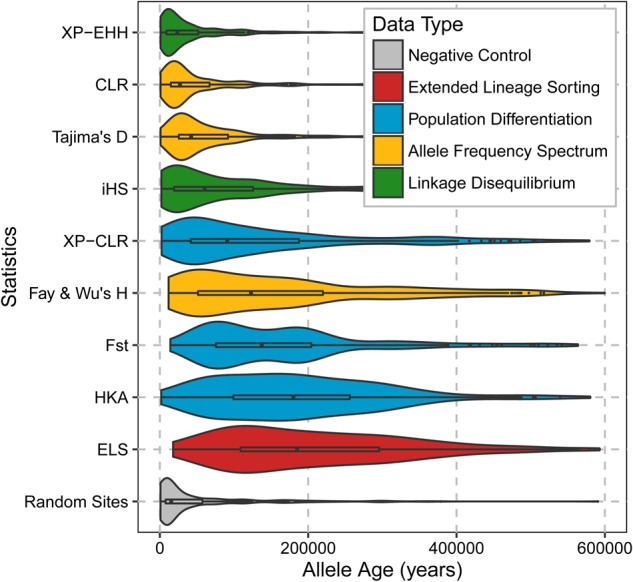
Distributions of estimated ages of the modern human segregating derived variants with the highest frequency in putatively selected regions or the age of the derived variants at sites identified by various genome-wide scans. Our candidate regions are labeled as ELS, for Extended Lineage Sorting; other candidate regions are from Pybus et al. (2014) and Cagan et al. (2016). The color coding indicates the type of signal detected by each method. Ages were estimated by ARGweaver (Rasmussen et al. 2014). We only report events between 0 and 600 kya.